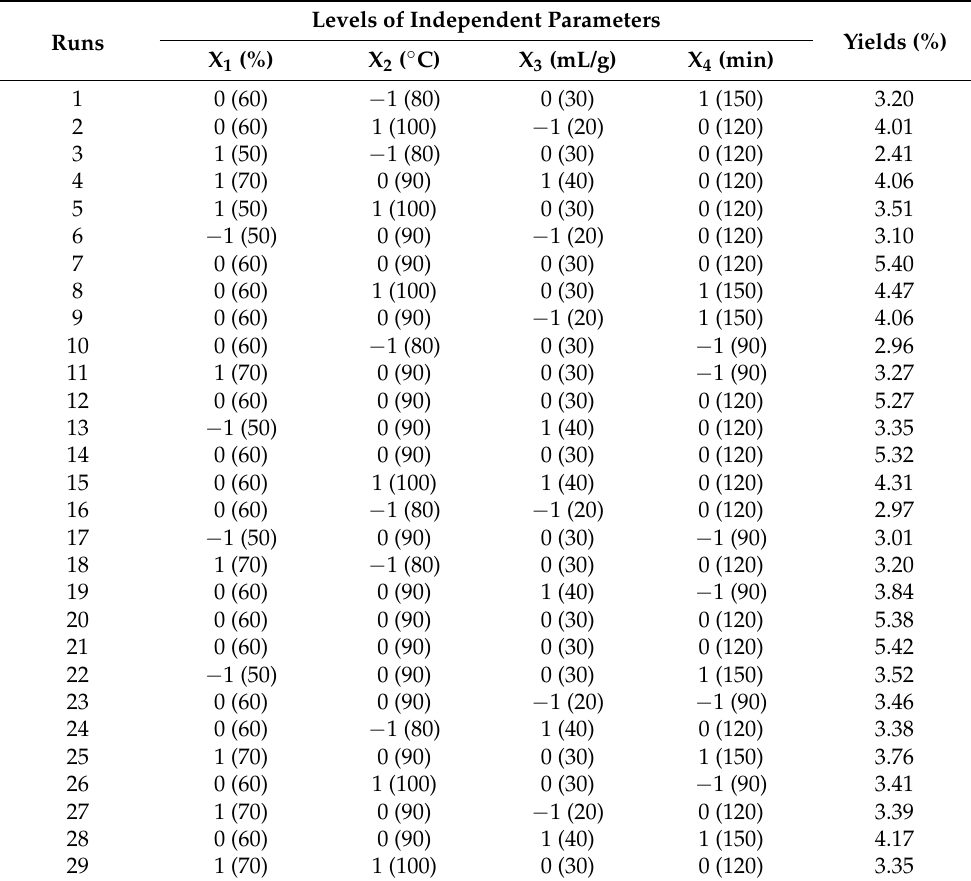
Table 1. The Box-Behnken design with independent variables and observed values of the extraction yield of polysaccharides from lotus